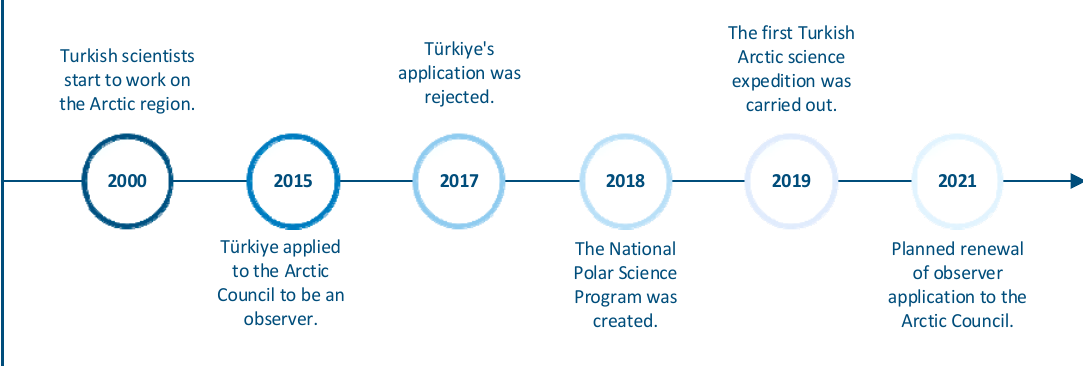
Figure 1. Timeline of Türkiye’s activities regarding the Arctic region.